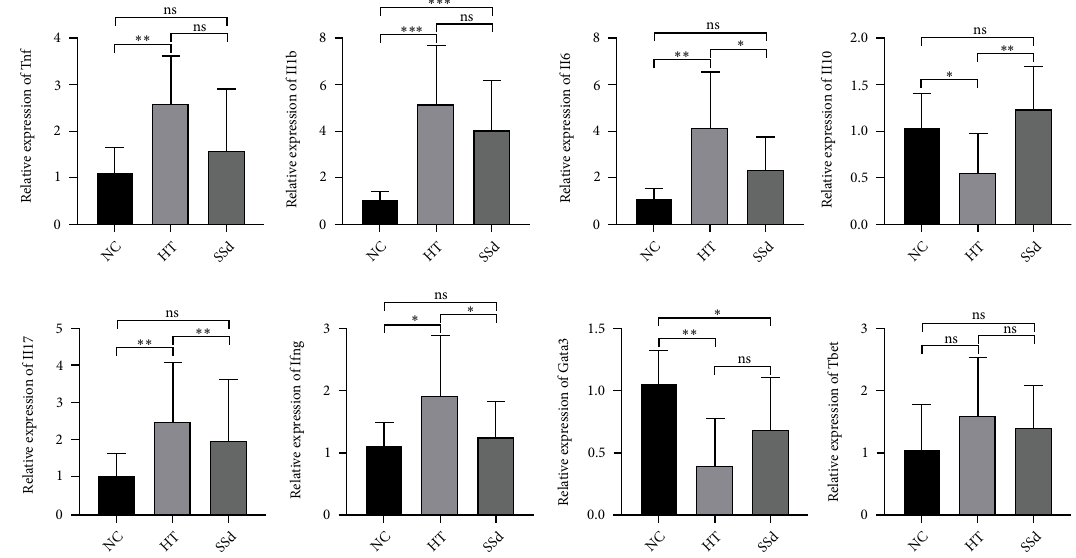
Figure 10: Expression levels of mRNA in mice spleen cells ( ∗∗∗ P < 0 : 001 , ∗∗ P < 0 : 01 , ∗ P < 0 : 05